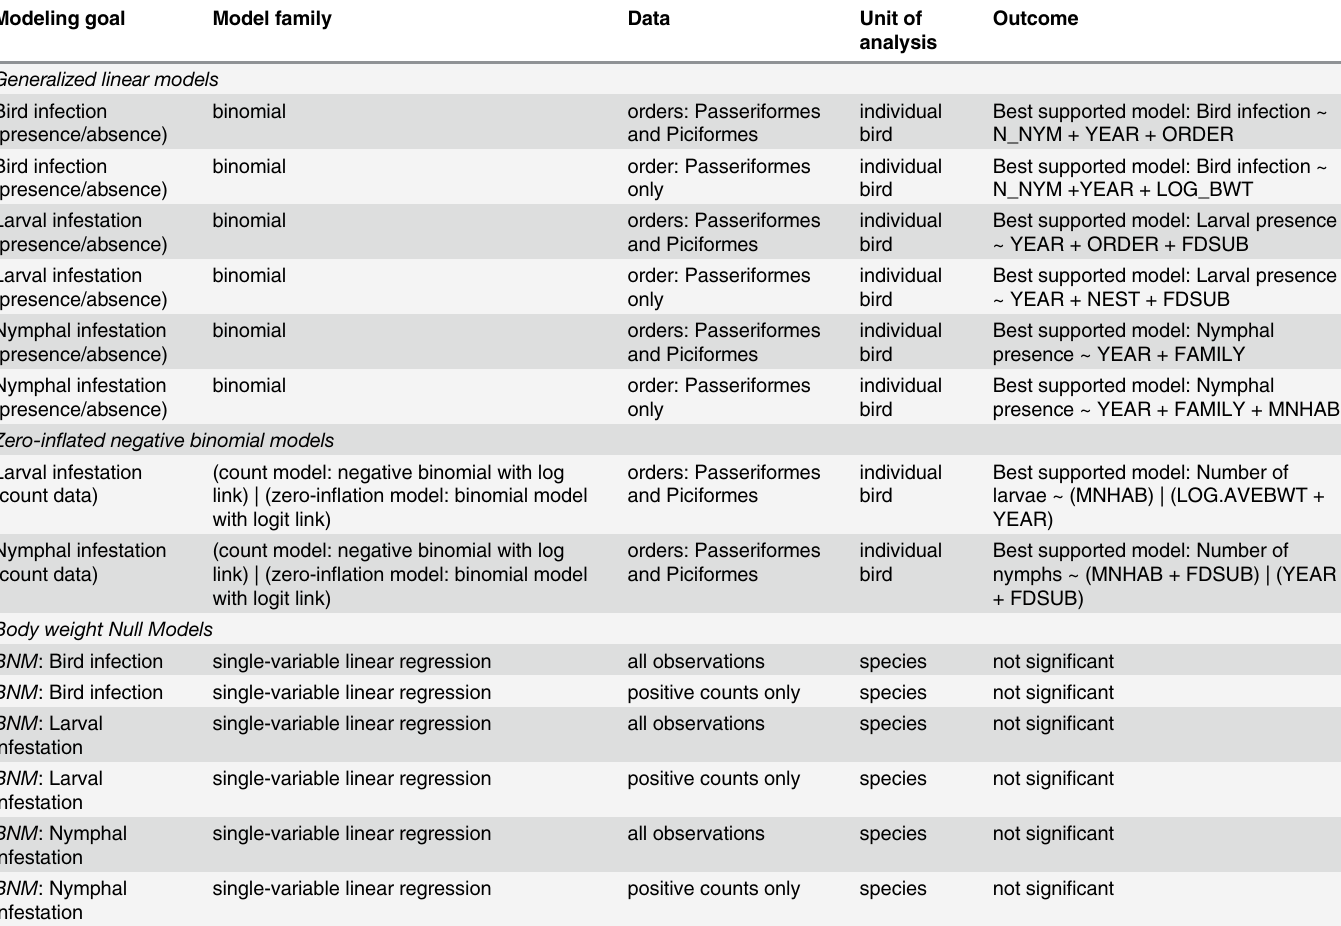
Table 3. Bird infection and tick infestation modeling goals and best supported models, based on AIC and AICc values. Modeling